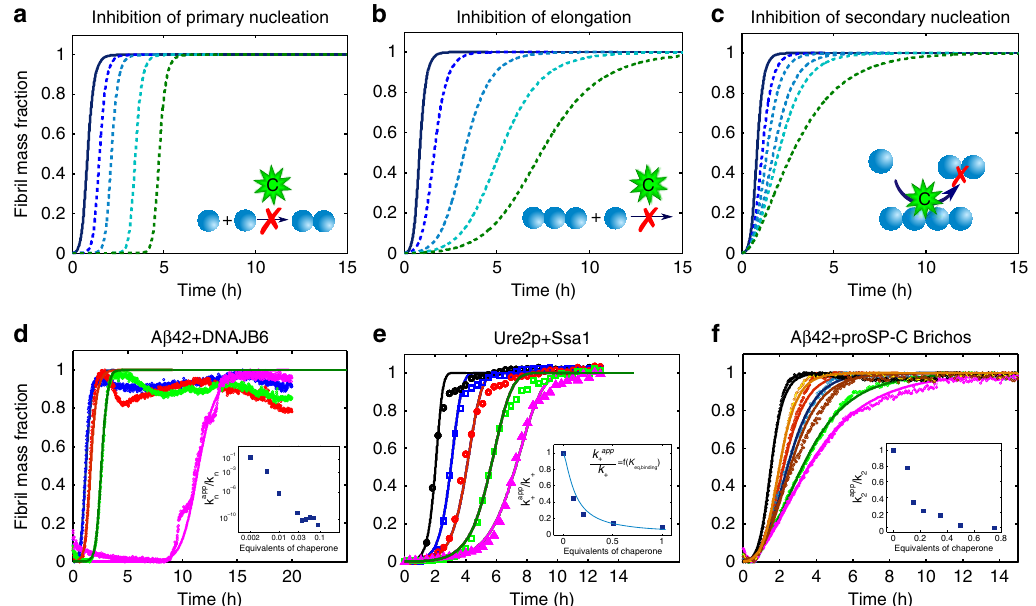
Figure 2 | Molecular chaperones can affect individual microscopic steps in the aggregation process. ( a – c ) Numerical integration of the master equations illustrates how perturbations of specific microscopic aggregation events modify in characteristic ways the global kinetic profiles. The analysis of the changes in the macroscopic profiles provides quantitative information on the microscopic events altered by the molecular chaperones. ( d – f ) To demonstrate the experimental consequences of the different mechanisms described in ( a – c ) we consider the aggregation kinetics of the A b 42 peptide and the prion protein Ure2p of in the absence and presence of different molecular chaperones at increasing concentrations. ( d ) DNAJB6 inhibits strongly the primary nucleation rate of unseeded 3 m M A b 42 aggregation reactions in phosphate buffer pH 8.0 at 37 (cid:2) C (ref. 31); ( e ) a member of the Hsp70 family (Ssa1) suppresses specifically the fibril elongation rate in the aggregation process of 30 m M Ure2p in Tris buffer pH 7.5 at 30 (cid:2) C (ref. 32); ( f ) a molecular chaperone belonging to the Brichos family (proSP-C Brichos) inhibits specifically the secondary nucleation rate in the aggregation of 3 m M A b 42 in phosphate buffer pH 8.0 at 37 (cid:2) C (ref. 33). The molecular equivalents of chaperones as well as the microscopic rate constants as a function of molecular chaperone concentration, evaluated by fitting the experimental data with Equation 1, are shown in the inserts. The continuous line in the inset in ( e ) corresponds to the evaluation of the binding equilibrium constant according to Equation 4. NATURE COMMUNICATIONS|7:10948|DOI: